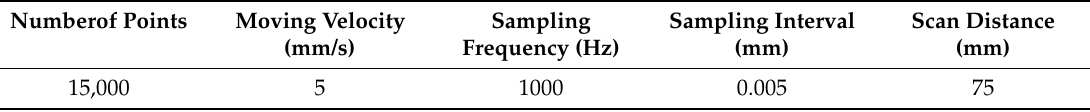
Table 1. Settings for pavement texture scan.